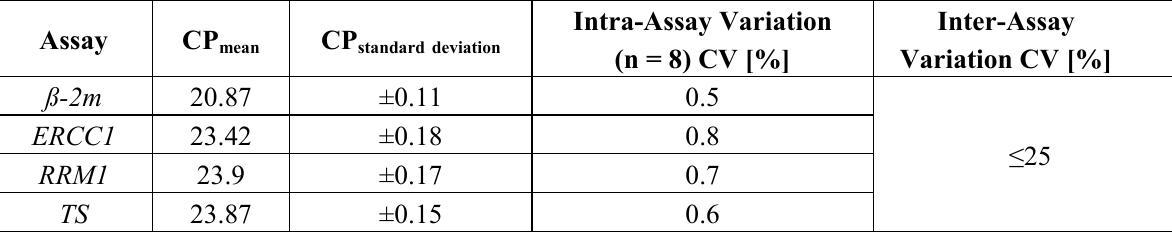
Table 6. Assay variations are based on CP variation and expressed as CP CP and CV (coefficient of standard deviation